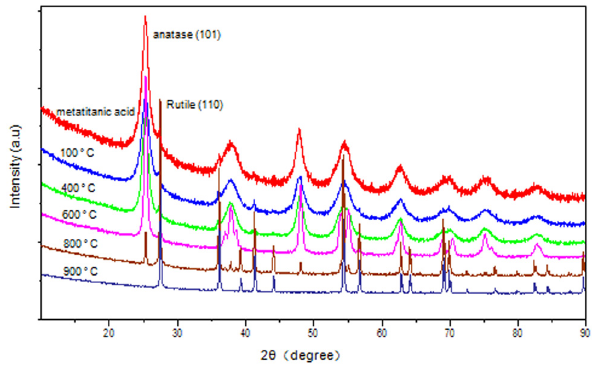
Figure 3: XRD patterns of metatitanic acid and its calcined samples at di ff erent temperatures.